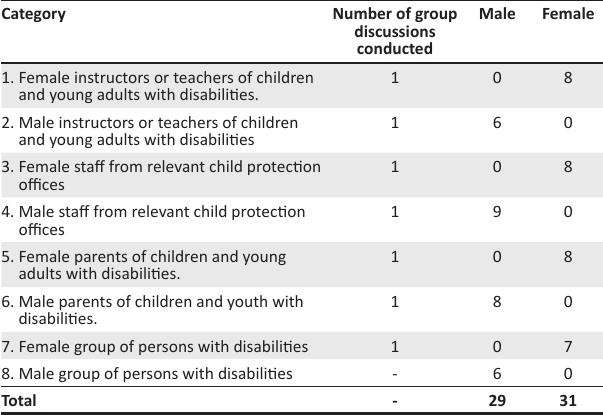
TABLE 3: Characteristics of participants in the group discussions. Category